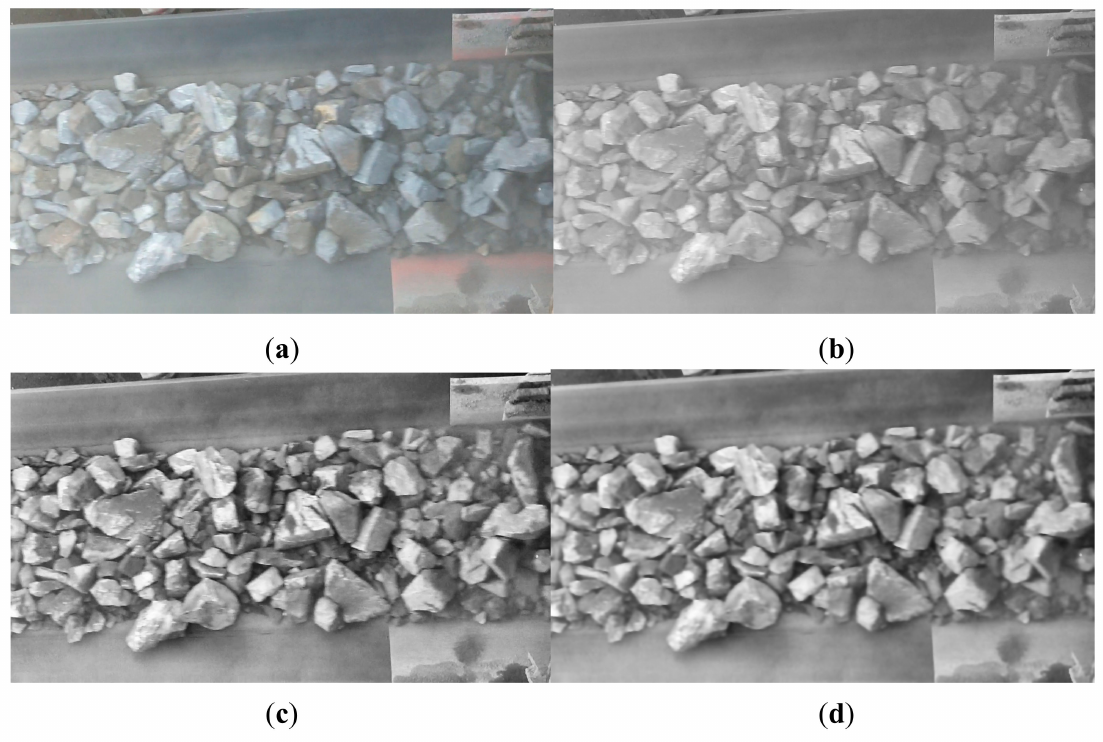
Figure 1. Images after each preprocessing step: ( a ) Original image, ( b ) Grayscale image, ( c ) Image after CLAHE operation, ( d ) Image after bilateral